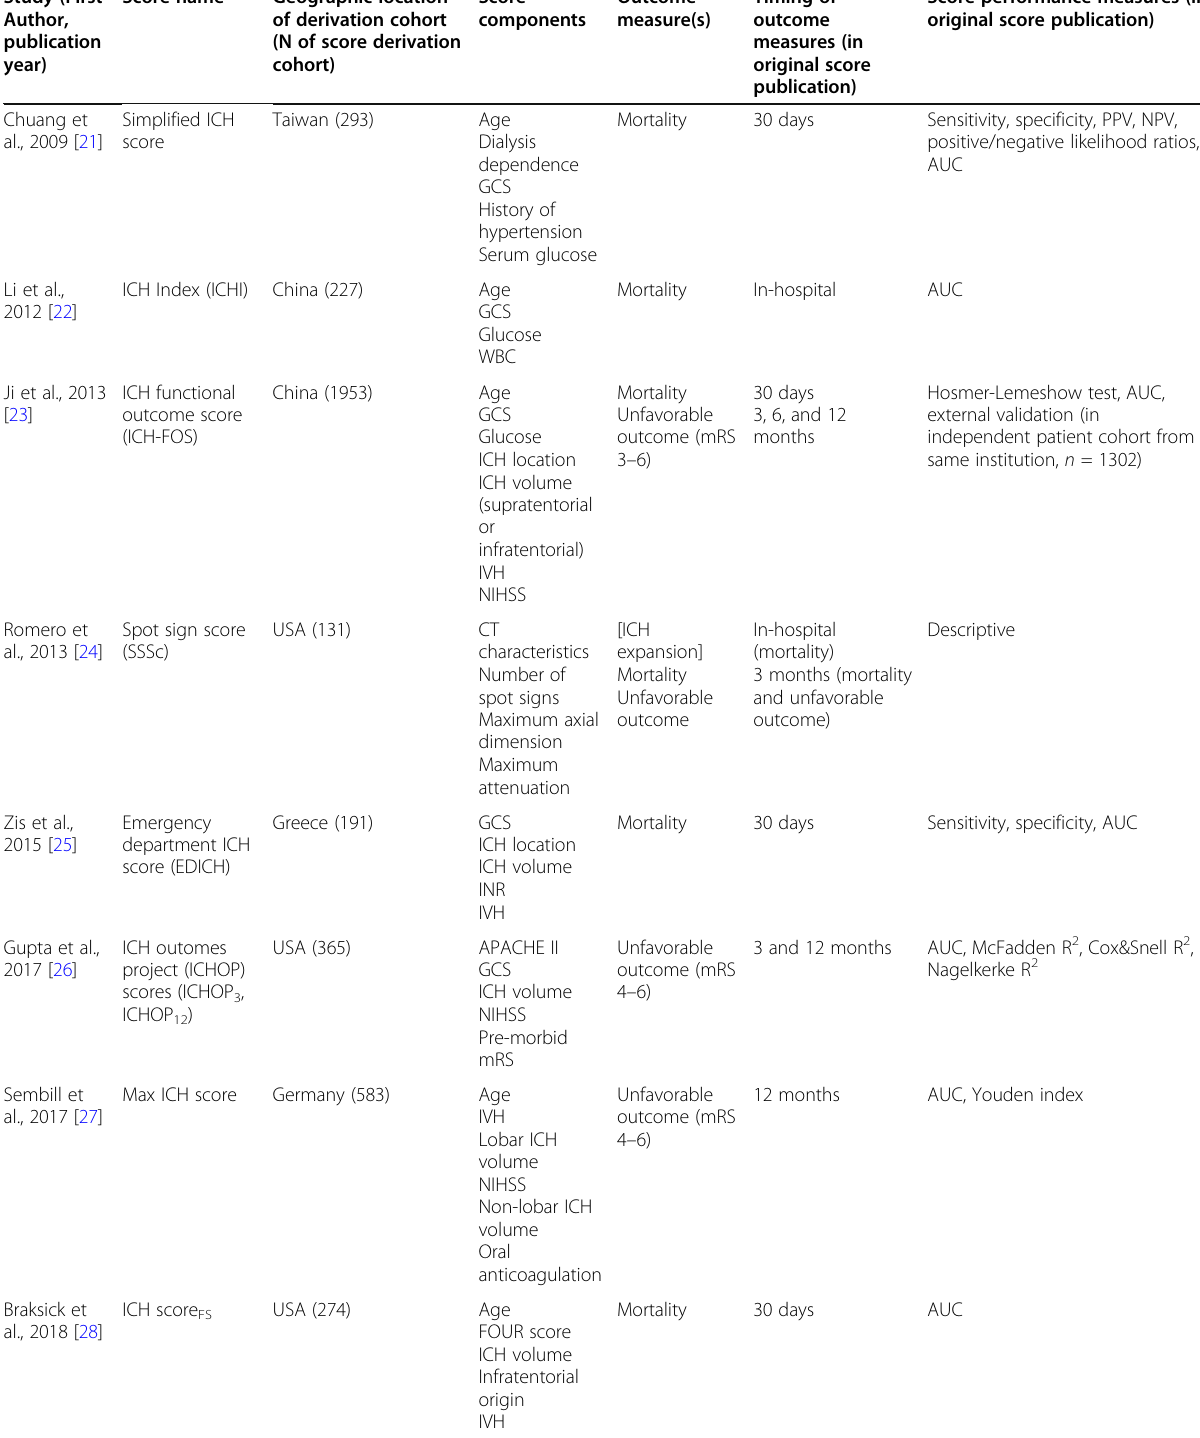
Table 1 Summary of Literature Search: scores to prognosticate outcome after spontaneous intracerebral hemorrhage